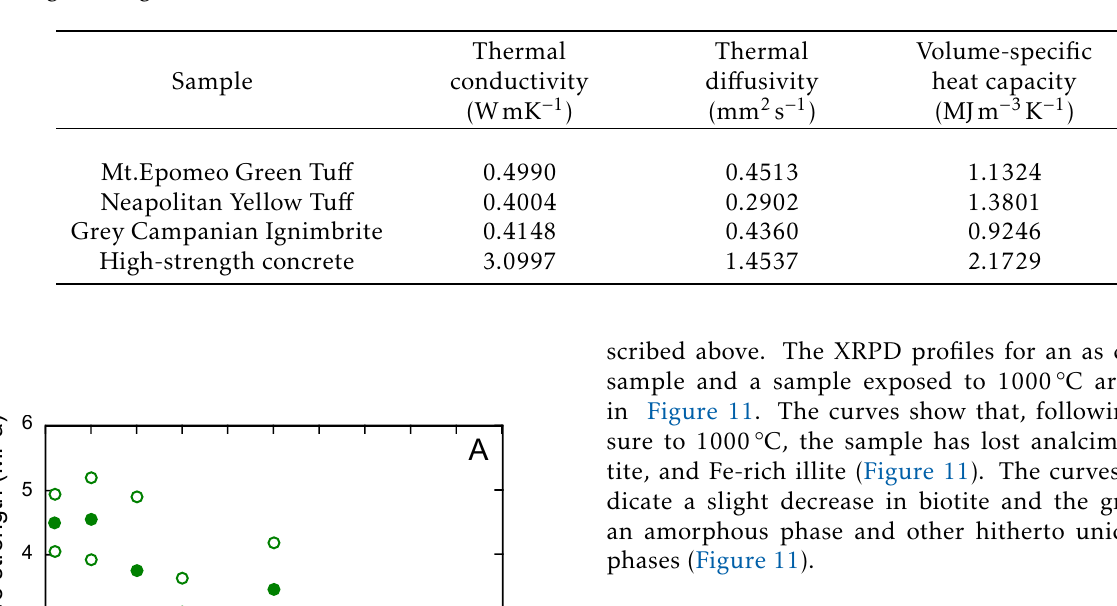
Table 3 – Thermal properties of Mt.Epomeo Green Tu ff , Neapolitan Yellow Tu ff , Grey Campanian Ignimbrite, and high-strength concrete.